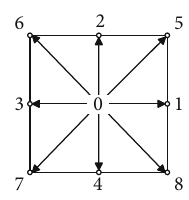
Figure 1: Schematic of the D2Q9